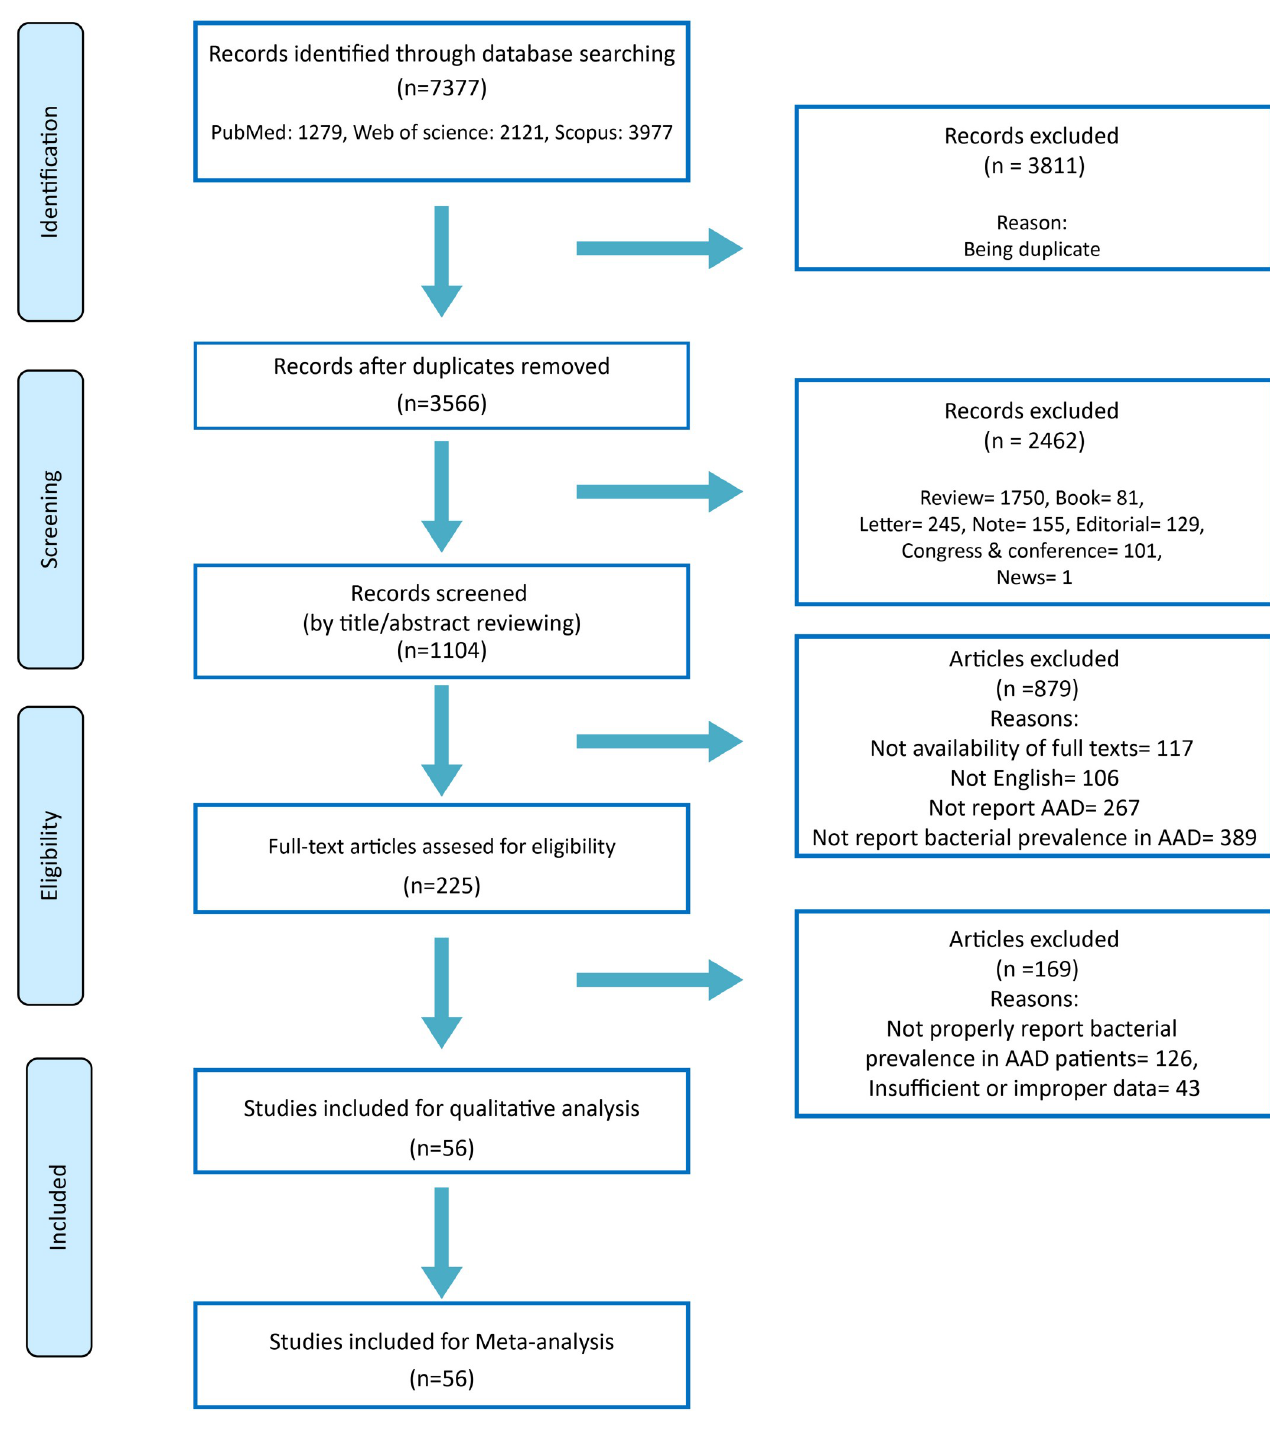
Fig 1. Systematic literature review flow diagram.